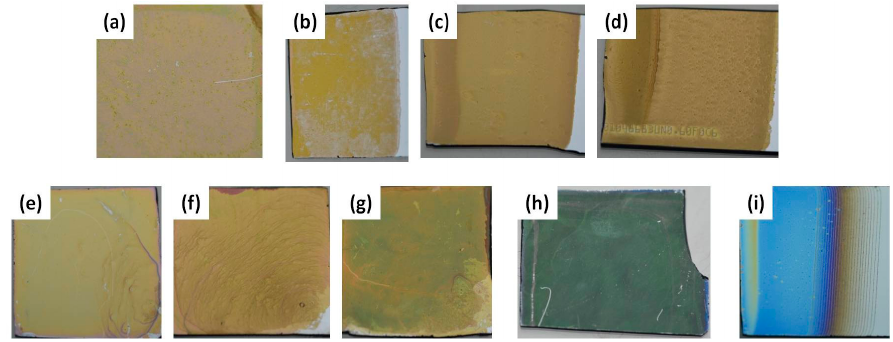
Figure 1. Photographs of MOF optical thin films. ( a ) OTF-SP, ( b ) OTF-DP-1, ( c ) OTF-DP-3, ( d ) OTF-DP-5, ( e ) OTF-SA-1, ( f ) OTF-SA-2, ( g ) OTF-SA-3, ( h ) OTF-DG, ( i ) OTF-LBL.